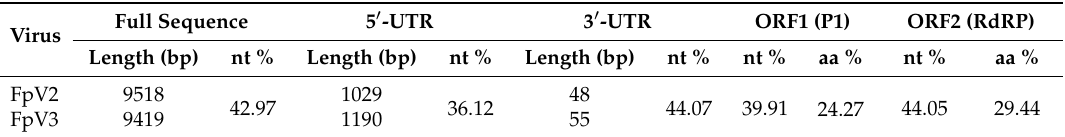
Figure 3. Multiple alignments of the amino acid sequences of the conserved motifs in the ORF2-coded RNA dependent RNA polymerase (RdRp) of FpV2, FpV3, and related viruses in the possible unassigned family. See legend to Figure 4 for abbreviations of the virus names. Motif I–VIII involves the eight conserved motifs characteristic of RdRps of RNA viruses. Identical residues are shaded. Asterisks, colons, and dots indicate identical amino acid residues (shaded gray), conserved amino acid residues, and semi-conserved amino acid residues, respectively. Numbers in gaps represent the number of amino acid residues apart from the motifs. Table 1. Nucleotide and amino acid identities between FpV2 and FpV3.